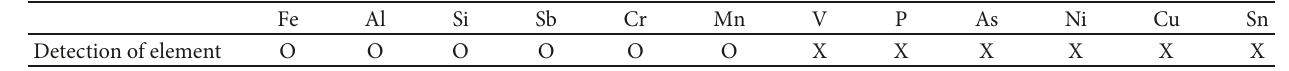
Table 1: Atomic determination of impurities in titanium tetrachloride via SEM-EDS.